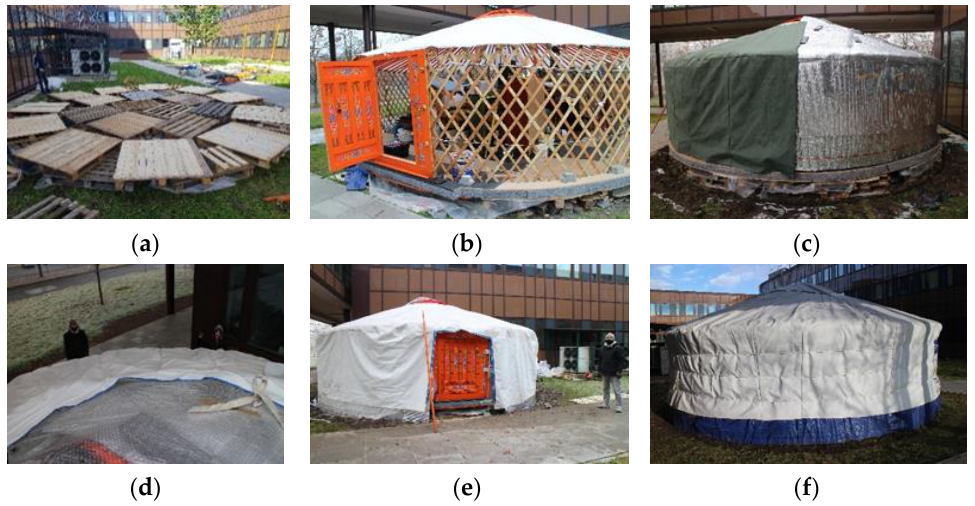
Figure 3. The materials used in the yurt tested in Cracow, Poland (photographs taken by Piotr Śliwinski during construction of Mongolian yurt in Cracow in 2020). ( a ) wooden pallets supporting yurt; ( b ) walls of the yurt and the first internal layer, white fabric; ( c ) the second layer, aluminum films with PE foam and spacer strips of polystyrene, the third layer green tarpaulin; ( d ) fourth layer, bubble foil; ( e ) the fifth layer, white protective synthetic material; ( f ) final view of modified yurt.